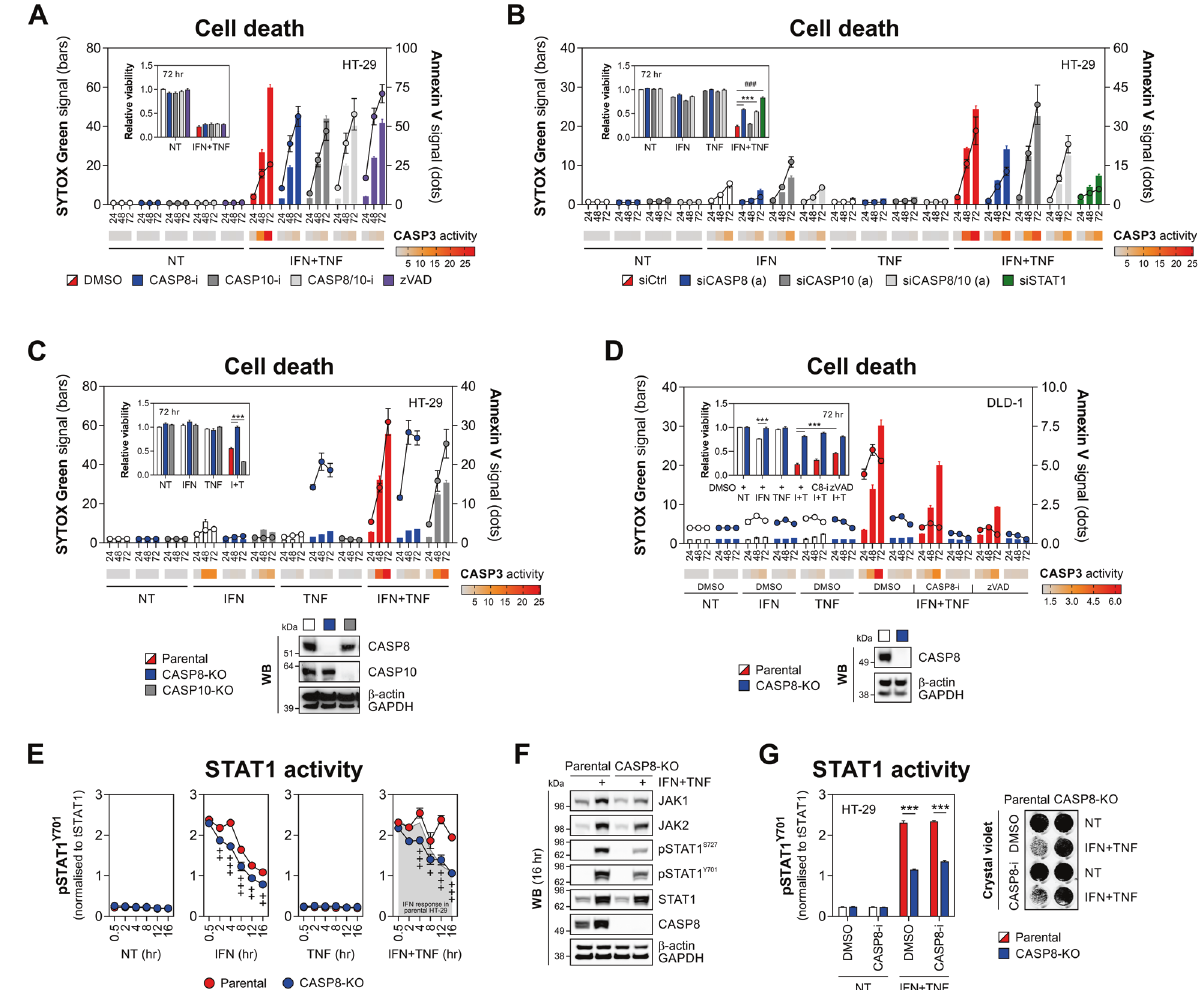
Fig. 6 Caspase-8 nonenzymatic function is required for IEC killing by IFN- γ /TNF- α . A HT-29 cells were pretreated for 1 h with vehicle (DMSO), caspase-8 inhibitor (Z-IETD, 10 μ M), caspase-10 inhibitor (Z-AEVD, 10 μ M) or zVAD (20 μ M), followed by IFN- γ /TNF- α (10 ng/ml each). SYTOX Green/Annexin V signals and caspase-3 activity (heatmap) were recorded at indicated times, and relative viability was measured at 72 h (inner graph). B HT-29 cells were transfected with a nontargeting siRNA (siCtrl), siCASP8, siCASP10 or a positive control siRNA (siSTAT1), followed by IFN- γ /TNF- α (10 ng/ml each) for 72 h. SYTOX Green/Annexin V signals and caspase-3 activity (heatmap) were recorded at indicated times, and relative viability was measured at 72 h (inner graph). For both targets, siRNA ’ s 'a' were used. C Parental, CASP8 or CASP10 knockout HT-29 cells were treated with IFN- γ /TNF- α (10 ng/ml each). SYTOX Green/Annexin V signals and caspase-3 activity (heatmap) were recorded at indicated times, and relative viability was measured at 72 h (inner graph). Western blot validation of CASP8/10 knockout (bottom). D Parental or CASP8 knockout DLD-1 cells were pretreated for 1 h with vehicle (DMSO), caspase-8 inhibitor (Z-IETD, 10 μ M) or zVAD (20 μ M), followed by IFN- γ /TNF- α (10 ng/ml each). SYTOX Green/Annexin V signals and caspase-3 activity (heatmap) were recorded at indicated times, and relative viability was measured at 72 h (inner graph). Western blot validation of CASP8 knockout (bottom). E STAT1 activity was measured by HTRF assay in parental and CASP8 knockout HT-29 treated with IFN- γ and/or TNF- α (10 ng/ml each) for indicated times. F Western blot analysis of JAK1/2, STAT1 (total, Y701- and S727-phosphorylated) and CASP8 expression in parental and CASP8 knockout HT-29 treated with IFN- γ /TNF- α (10 ng/ml each) for 16 h. G STAT1 activity at 16 h measured by HTRF assay (left), and crystal violet staining at 72 h (right) in parental and CASP8 knockout HT-29 pretreated for 1 h with DMSO or caspase-8 inhibitor (Z-IETD, 10 μ M), followed by IFN- γ /TNF- α (10 ng/ml each). Data were mean ± SEM of n = 3 independent experiments. *** p < 0.001 (two-way ANOVA with Tukey ’ s multiple comparisons test), + p < 0.05, ++ p < 0.01 and +++ p < 0.001 (two-way ANOVA with Bonferroni ’ s multiple comparisons test vs. time point-matched parental HT-29 cells), ### p < 0.001 (unpaired t -test). NT non-treated, C8-i/CASP8-i caspase-8 inhibitor, CASP10-i caspase-10 inhibitor, KO knockout, I + T IFN +